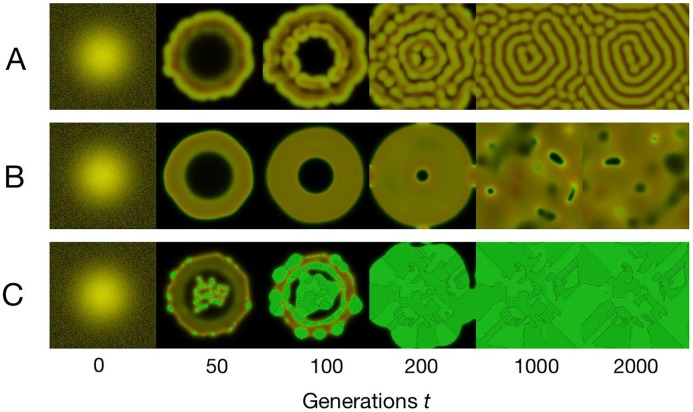
Pattern formation under directed migration.Snapshots of the density distribution of cooperators (green) and defectors (red) across the periodic L × L domain at time t = 0, 50, 100, 200, 1000, 2000. The color brightness indicates the density with coexistence (yellow) and vacant space (black). (A) Spreading defectors spontaneously form and settle in quasi-steady patterns (RD = 8). (B) Chaotic spatio-temporal dynamics unfold for hunting defectors (AD = 4). (C) Aggregating cooperators induce positive feedback: as more cooperator leave scarcely populated areas in favor of highly cooperative locations, the divide between neighbouring areas grows and discontinuities can develop at the interfaces. (AC = 1) Parameters: public goods interaction: b = 1, r = 2.325, d = 1.2, N = 8, c = 1; diffusion: DC = DD = 0.1; directed movement: AC = AD = RC = RD = 0, unless otherwise indicated; numerical discretization in space and time: L = 75, dx = 0.375, dt = 0.01; noisy Gaussian initial condition: u(x, y) = v(x, y) = 1/5 ⋅ exp[−((x − L/2)2 + (y − L/2)2)/162].